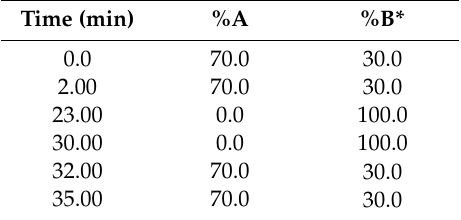
Table 3. Gradient elution conditions of HPLC-FLD and LC-MS / MS